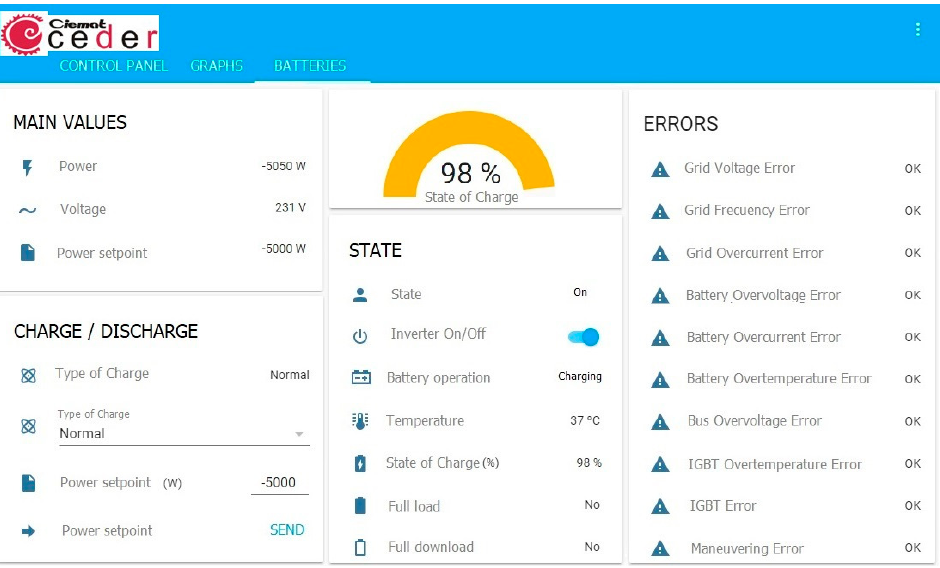
Figure 7. CEDER’s microgrid control framework developed in Home Assistant. Source: prepared by authors. The SCADA for the control of the batteries also has to be created, as can be seen in Figure 8. It shows how the batteries are in a charging process. At that moment, the mi- crogrid is injecting 1780 W to the batteries, which have a SOC of 98%, and 266 V.